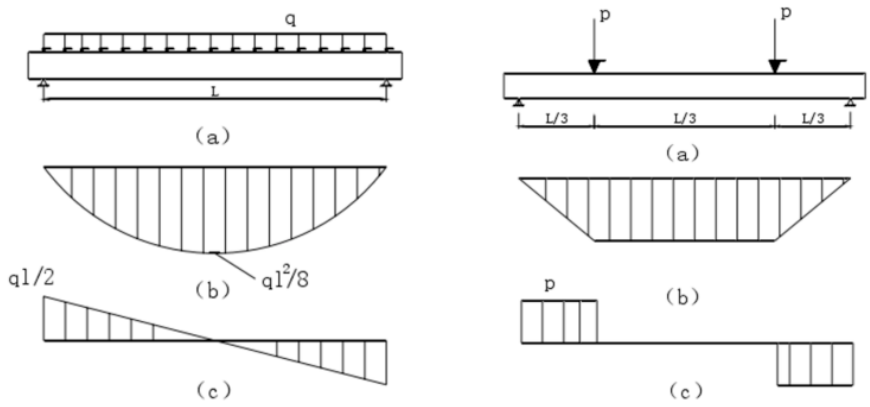
Figure 3. Load scheme: ( a ) Loading; ( b ) bending moment, and ( c ) shear force.